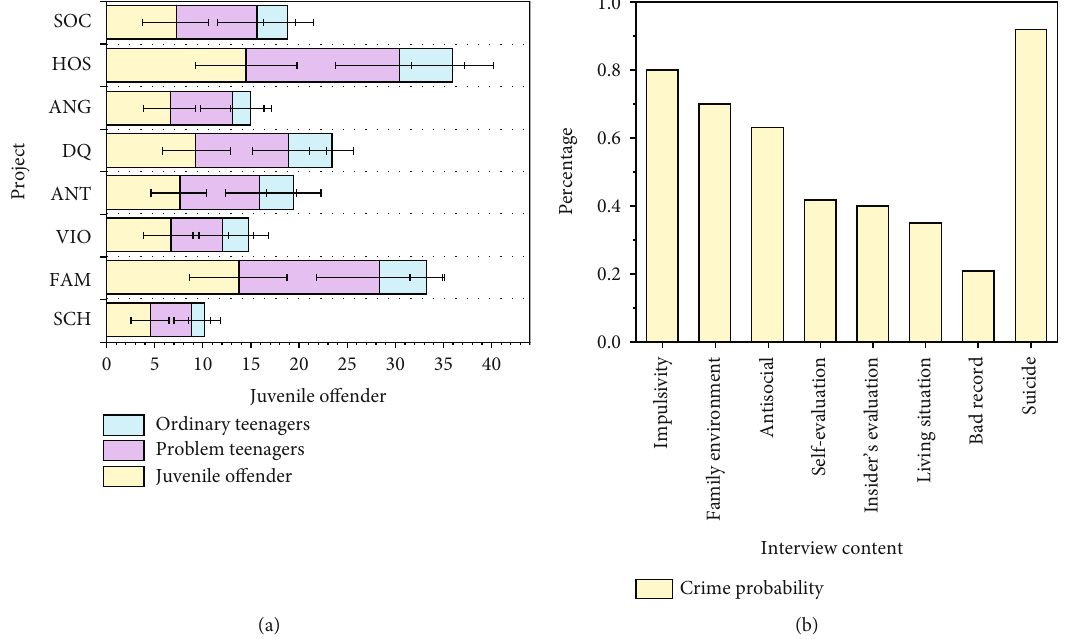
Figure 2: Scores of the YPPQ test of di ff erent groups of adolescents and the interview on problem youths ((a) YPPQ test and (b) structural interview results of problem